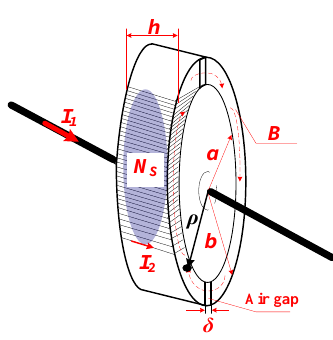
Figure 4. The structure of the energy harvesting device with an air gap.